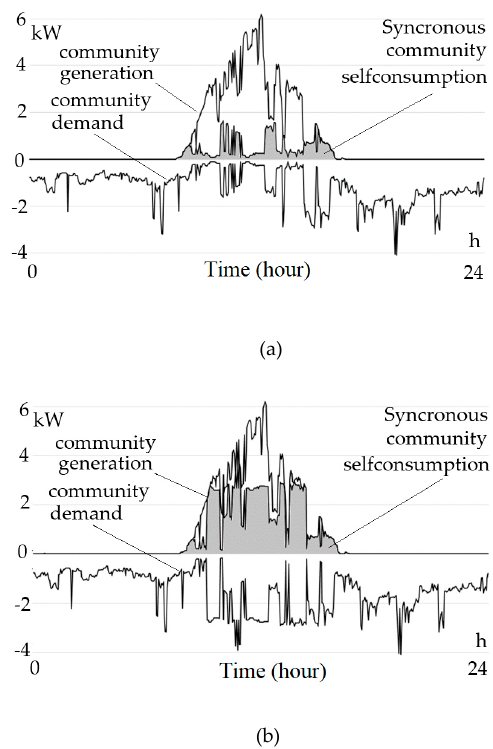
Figure 10. Community generation and demand for ( a ) Case0 and ( b ) Case1.